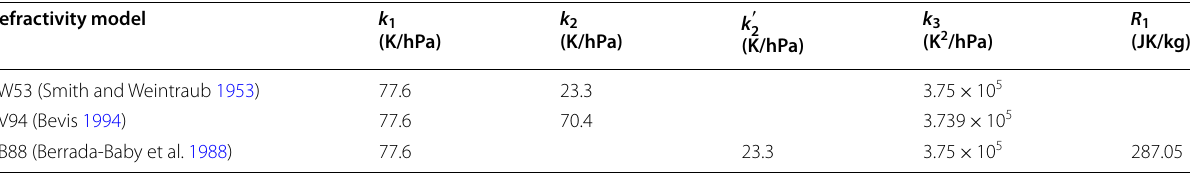
Table 2 List of the coefficients for each refractivity model Refractivity